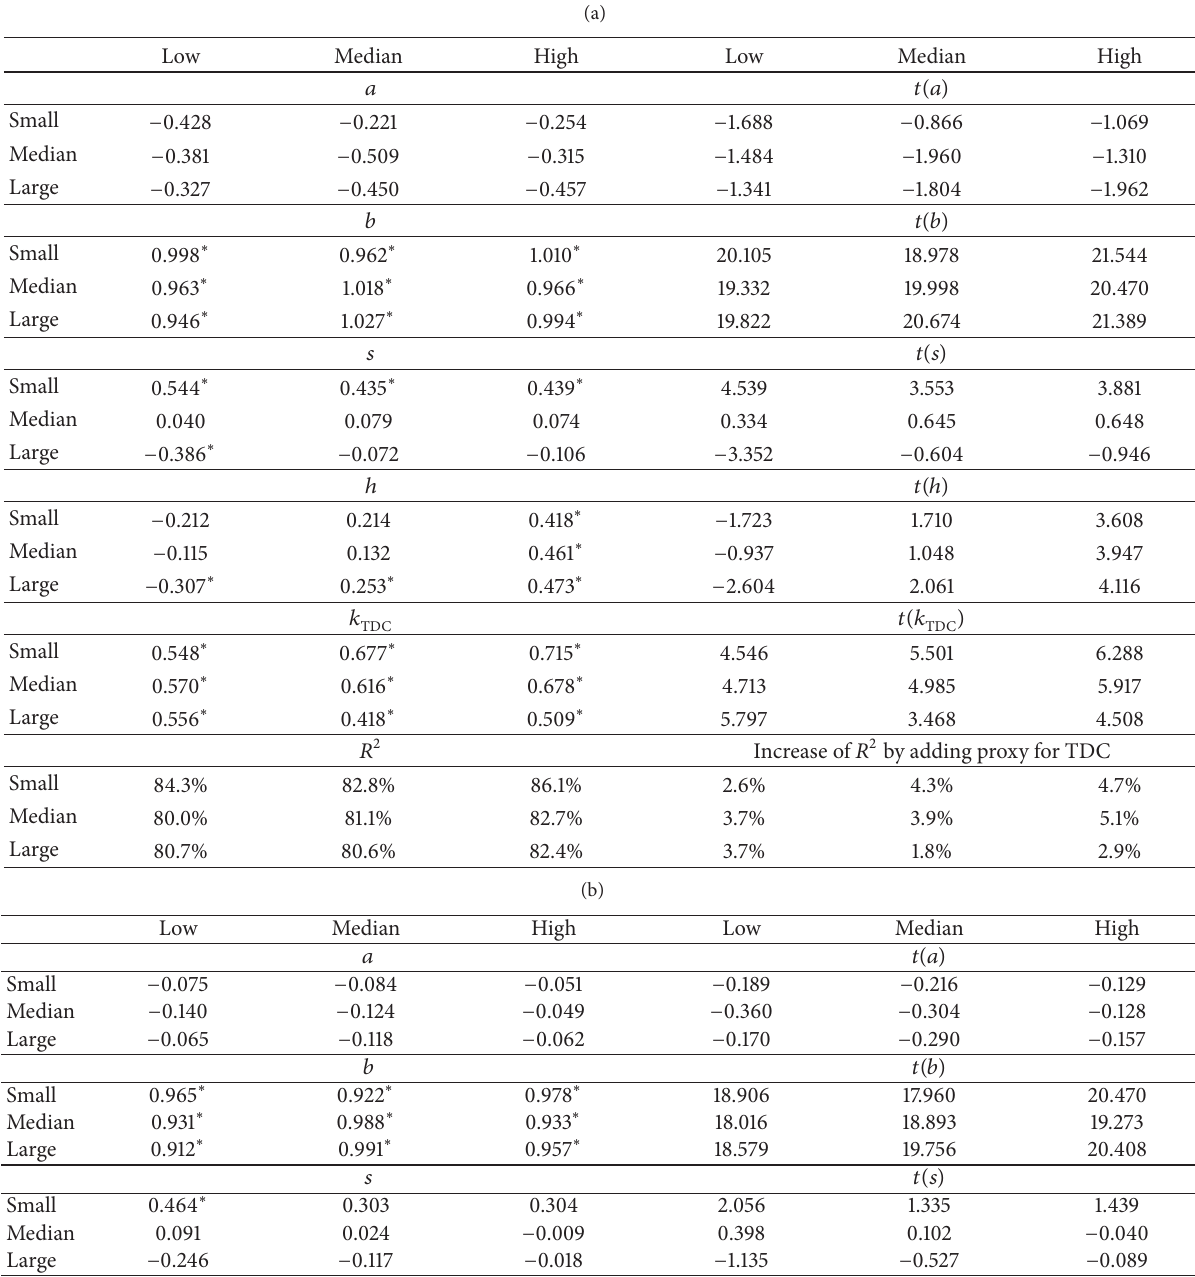
Table6:(a)RegressionofportfolioreturnsontheproxyfortaildependenceandFama-Frenchfactors.Thistableshowsresultsfromregressing each of the nine size and book-to-market value sorted portfolios’ excess returns on three factors in Fama-French model and the proxy for tail dependence; that is, 𝑅 𝑡 − RF 𝑡 = 𝑎 + 𝑏( RM 𝑡 − RF 𝑡 ) + 𝑠 SML 𝑡 + ℎ HML 𝑡 + 𝑘 TDC MP TDC + 𝑒 𝑡 , where 𝑅 𝑡 represent each portfolio’s returns, RM 𝑡 represent market returns, and RF 𝑡 are risk-free rates. SML, HML, and MP TDC are the proxies for size, book-to-market value, and tail dependence, respectively. “ ∗ ” denotes the fact that the corresponding coefficients are significantly different from zero at the confidence level of 5%. (b) Regression of portfolio returns on the proxies for tail dependence and all the other factors. This table shows results from regressing each of the nine size and book-to-market value sorted portfolios’ excess returns on three factors in Fama-French model, the proxy for tail dependence, and the proxies for other factors; that is, 𝑅 𝑡 − RF 𝑡 = 𝑎 + 𝑏( RM 𝑡 − RF 𝑡 ) + 𝑠 SML 𝑡 + ℎ HML 𝑡 + 𝑘 LEV MP LEV + 𝑘 E / P MP E / P + 𝑘 RM 𝑡 represent market returns, and RF 𝑡 are risk-free rates. SML, HML, MP LEV, MP E/P, MP ASQT, MP TURN, MP MTM, MP VOL, and MP TDC are, respectively, the proxies for size, book-to-market value, leverage, earning-price ratio, square root of Amihud’s measure, Turnover, momentum, volatility, and tail dependence. “ ∗ ” denotes the fact that the corresponding coefficients are significantly different